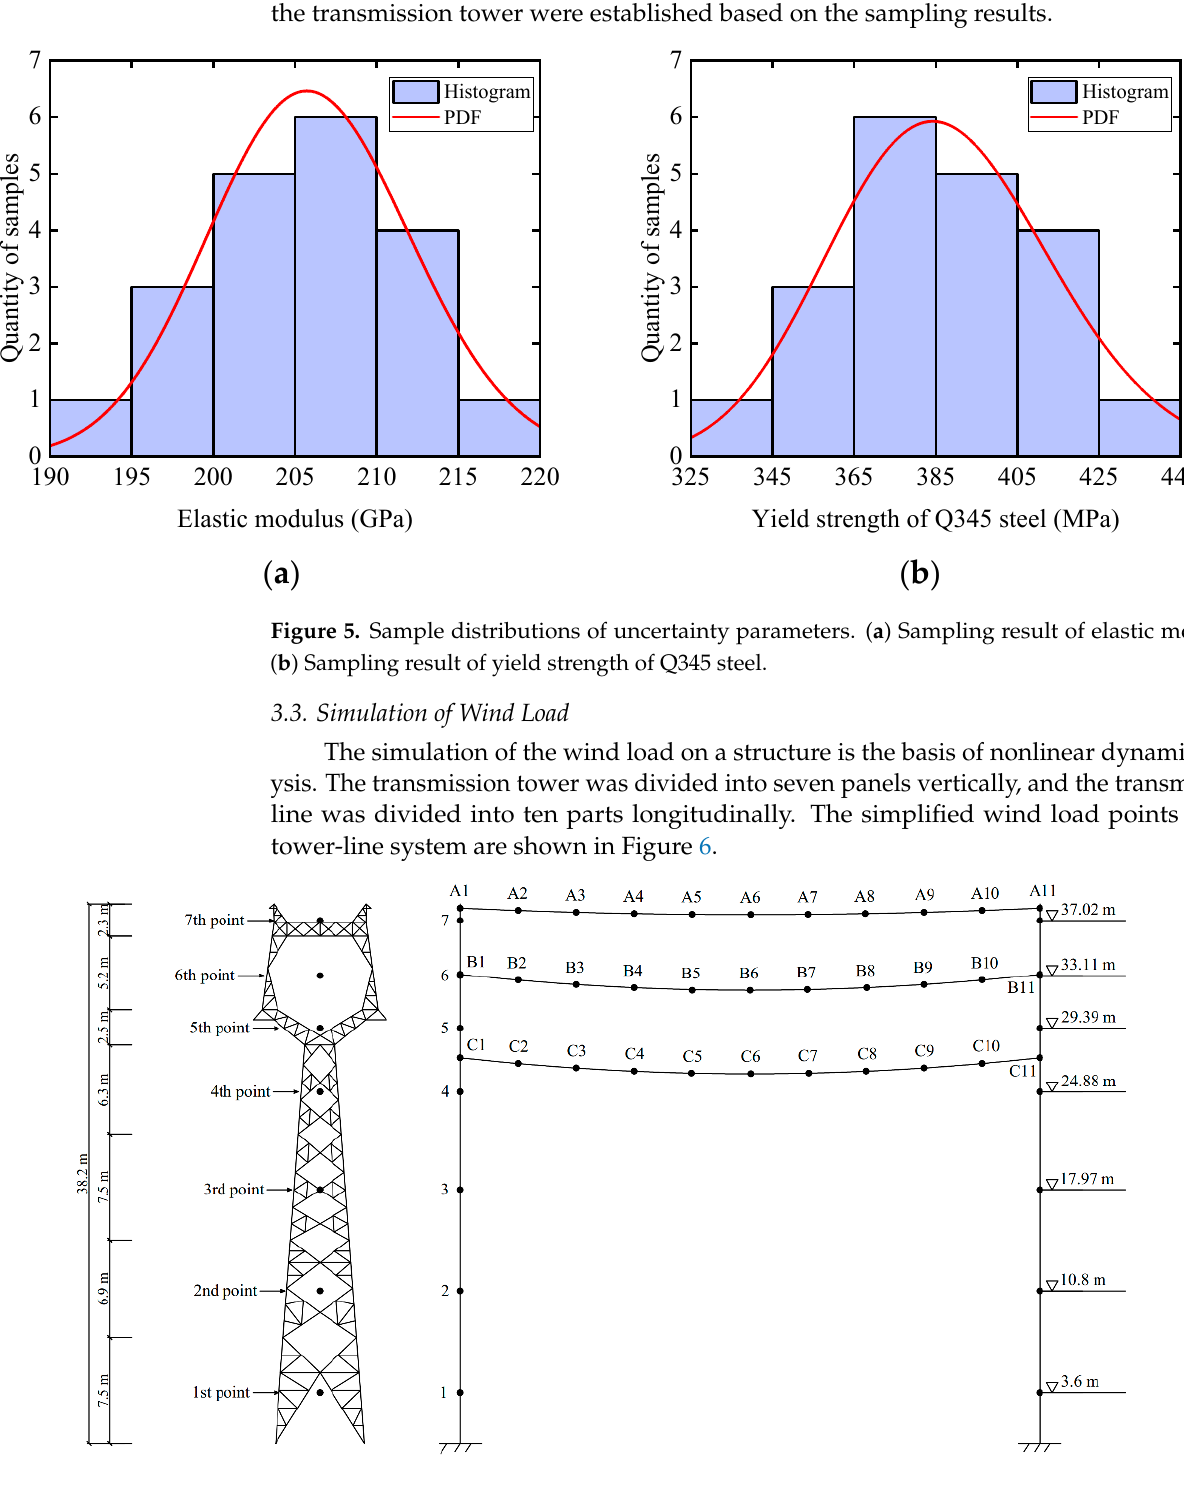
Figure 6. Schematic diagram of simplified wind load points. Atmospheric boundary-layer wind consists of static and fluctuating winds. The static wind speed was calculated according to the exponential law, and the fluctuating wind speed with the Davenport spectrum was simulated using the harmonic superposition method. The harmonic synthesis method uses spectral decomposition and trigonometric series superposition to realize the numerical simulation of random process samples [17]. The total time of the wind speed time series was 300 s. The time interval was 0.125 s, and